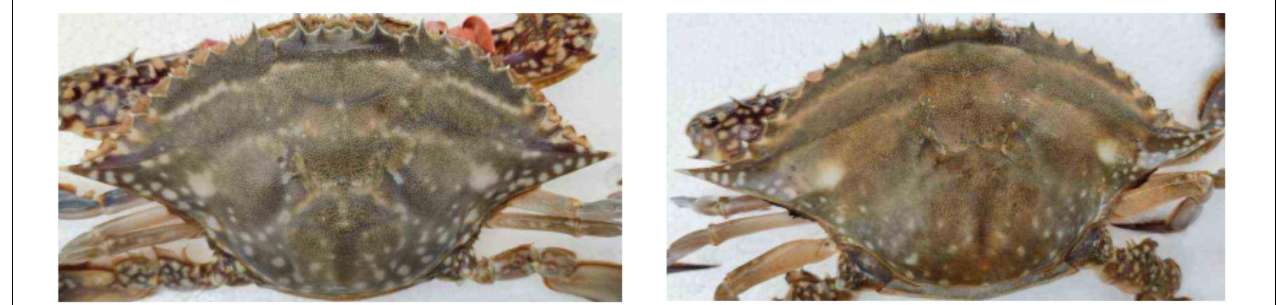
FIGURE 2 | Pictures of two P. trituberculatus